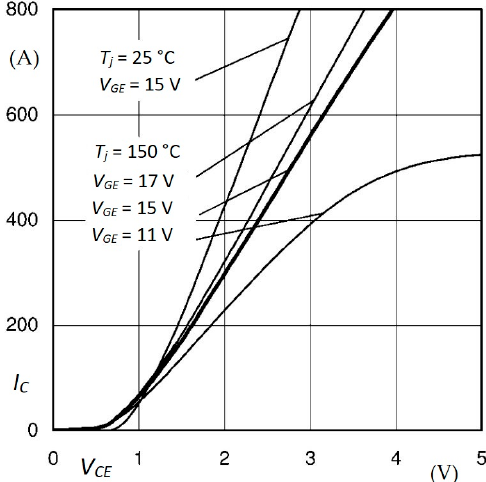
Figure 5. Typical switch forward characteristics representation.